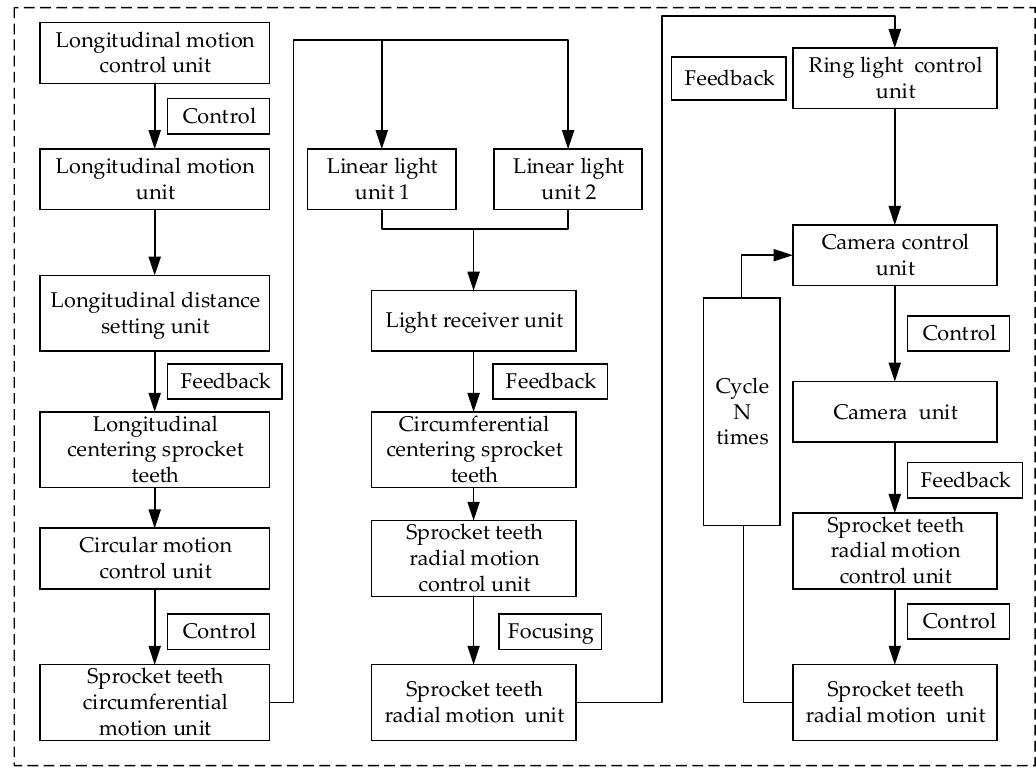
Figure 4. Technical route of sequence images acquisition.